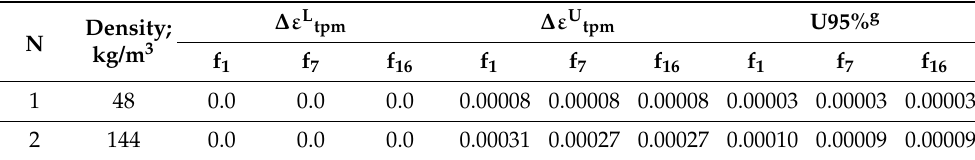
Table 4. Boundaries of changes caused by perimetral gaps, 1